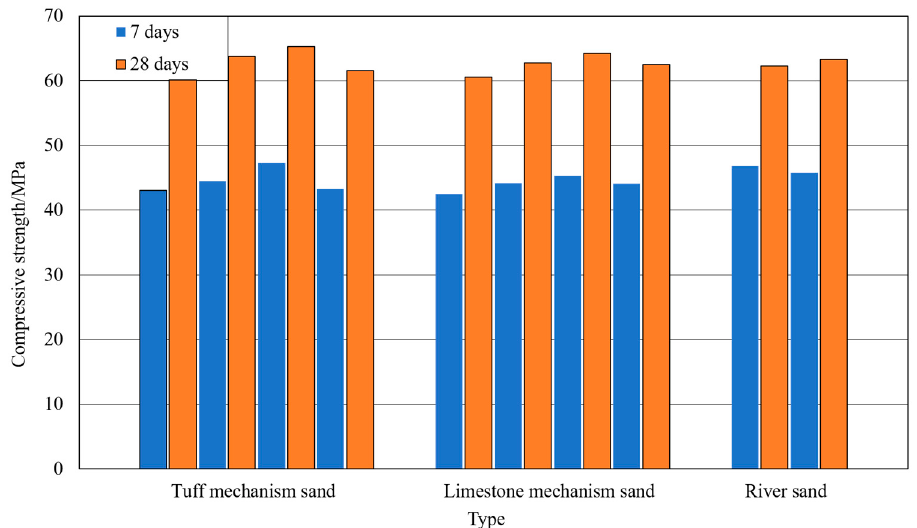
Figure 8. Compressive strength of concrete with different fine aggregate machine-made sand.